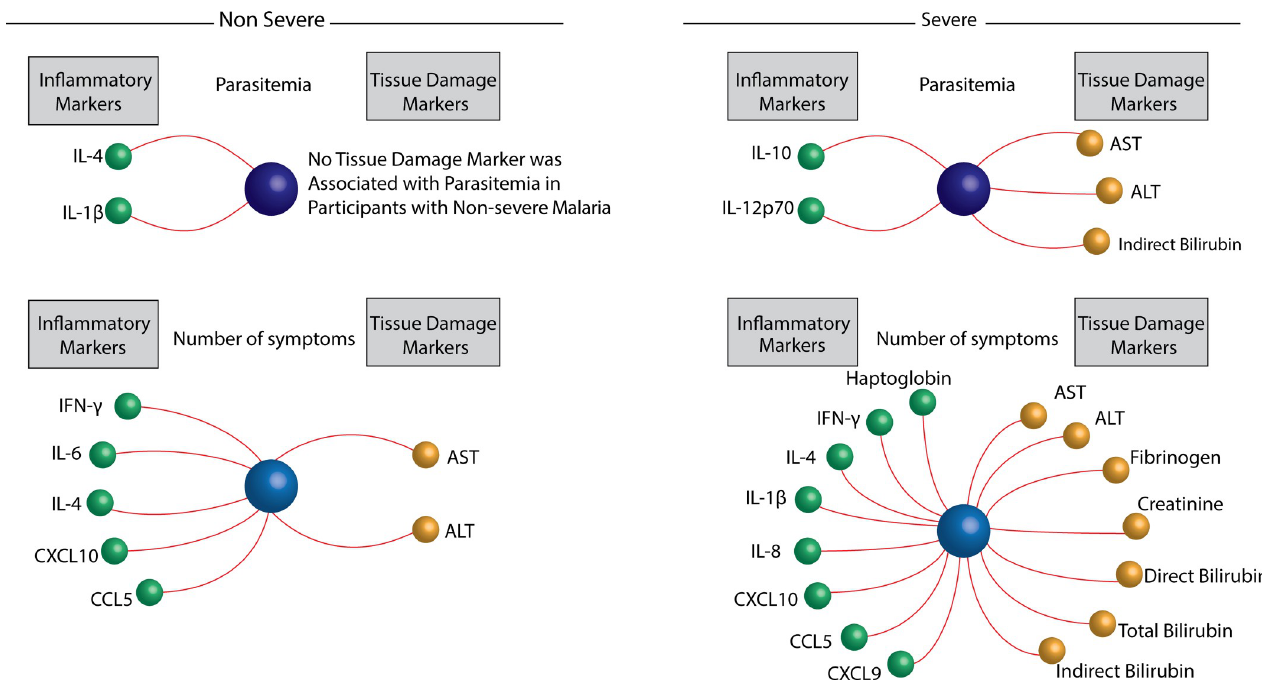
Fig 9. Identifying the factors associated with disease tolerance in Plasmodium vivax malaria. A Spearman correlation rank matrix analysis was used to identify the specific inflammatory or tissue damage markers which degree of disturbance is associated with parasitemia or number of symptoms (the latter are represented as central spheres in the network graphs) in patients non-severe or severe P . vivax as indicated. Each line represents a statistically significant correlation (p < 0.05) after adjustment for multiple measurements. Among the statistically significant correlations detected, only positive associations were